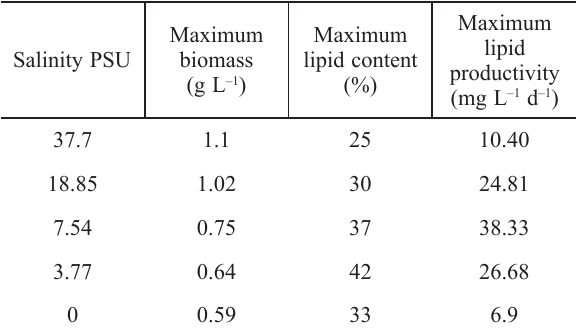
Table 4 – Effect of salinity variation and low nitrogen (18.75 mg L –1 ) on biomass, lipid content, and lipid